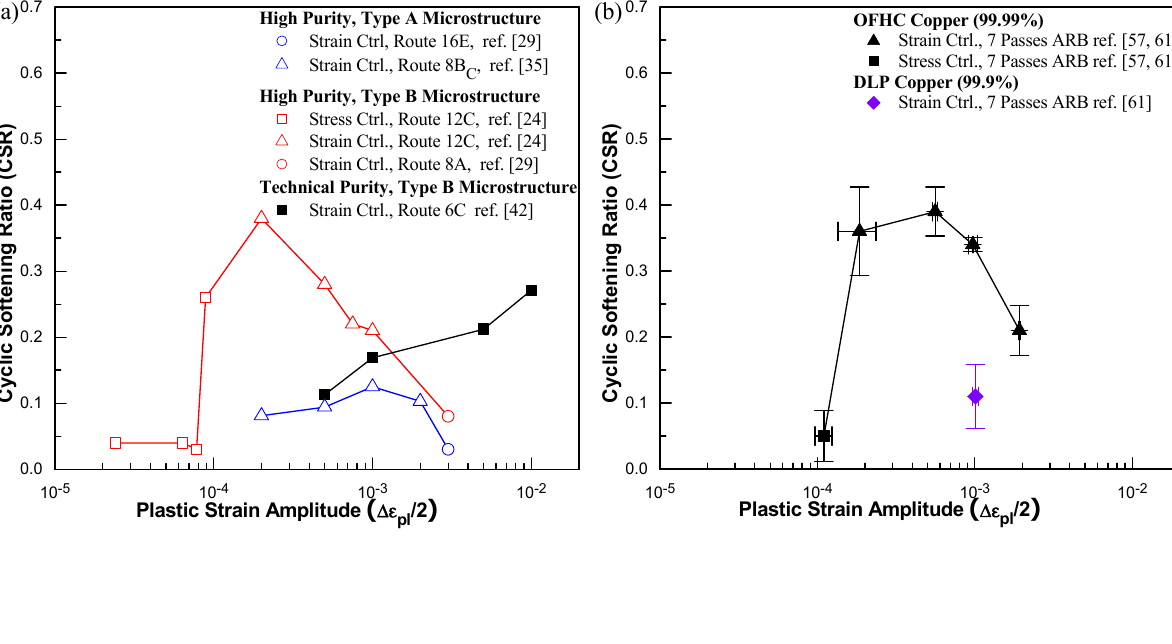
Figure 2. The trend of cyclic ratio according to [24] with respect to the applied plastic strain amplitudes of: ( a ) ECAPed copper of different purity levels processed with various ECAP parameters; and ( b ) ARBed copper of different purity